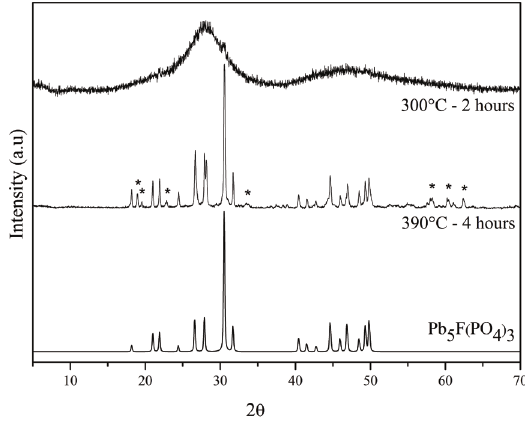
Figure 4. X-ray diffraction patterns of sample 50PbEY heat-treated at 300ºC for 2 hours, 390 °C for 4 hours and crystalline Pb F(PO ) reference. 5 4 3